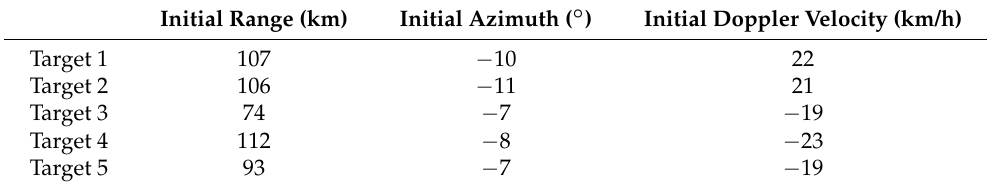
Table 1. Initial parameters of simulated